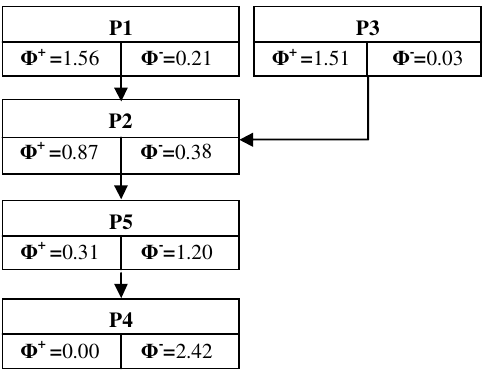
Figure 6. PROMETHEE I results for the alternative press